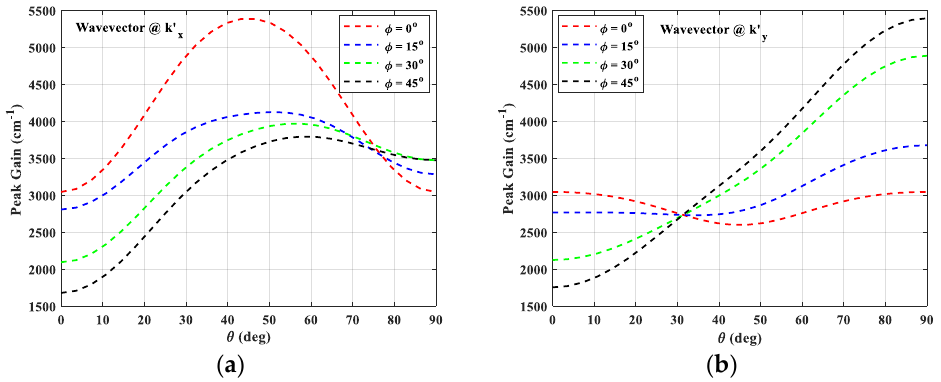
Figure 6. Plots of the material gain in strained InGaAs QW along the orthogonal plane wave vectors (cid:48) k with arbitrary crystal orientations. ( a ) k (cid:48) k and ( b )  ( a )  y x x and ( b ) k y with arbitrary crystal